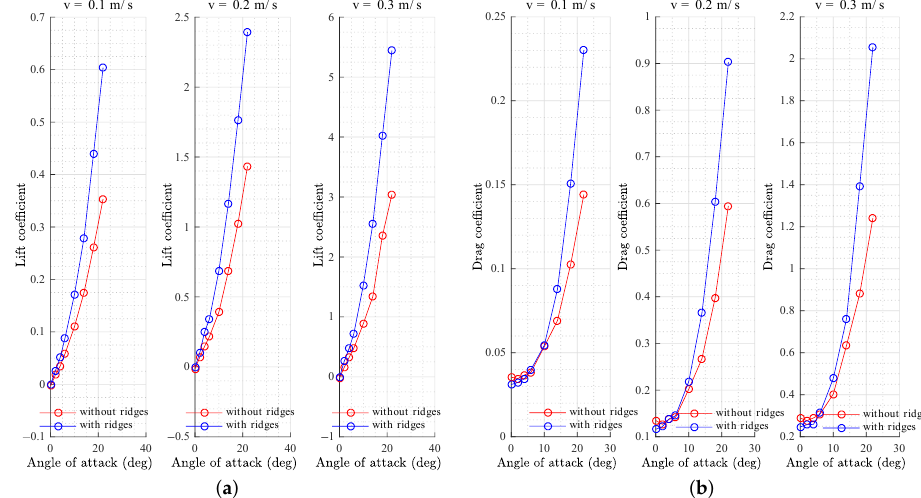
Figure 9. Lift ( a ) and drag ( b ) coefficients at different velocities.